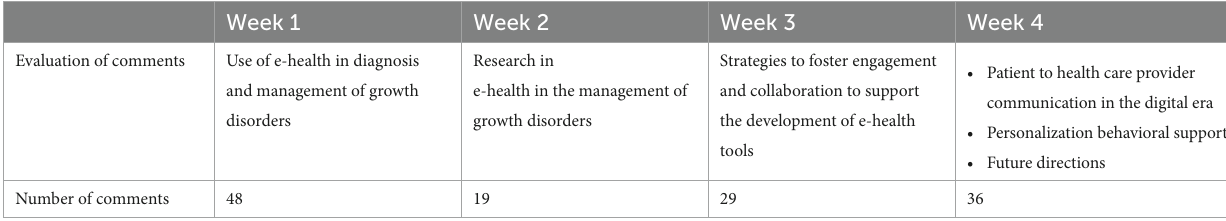
TABLE 5 Evaluation of comments over Week